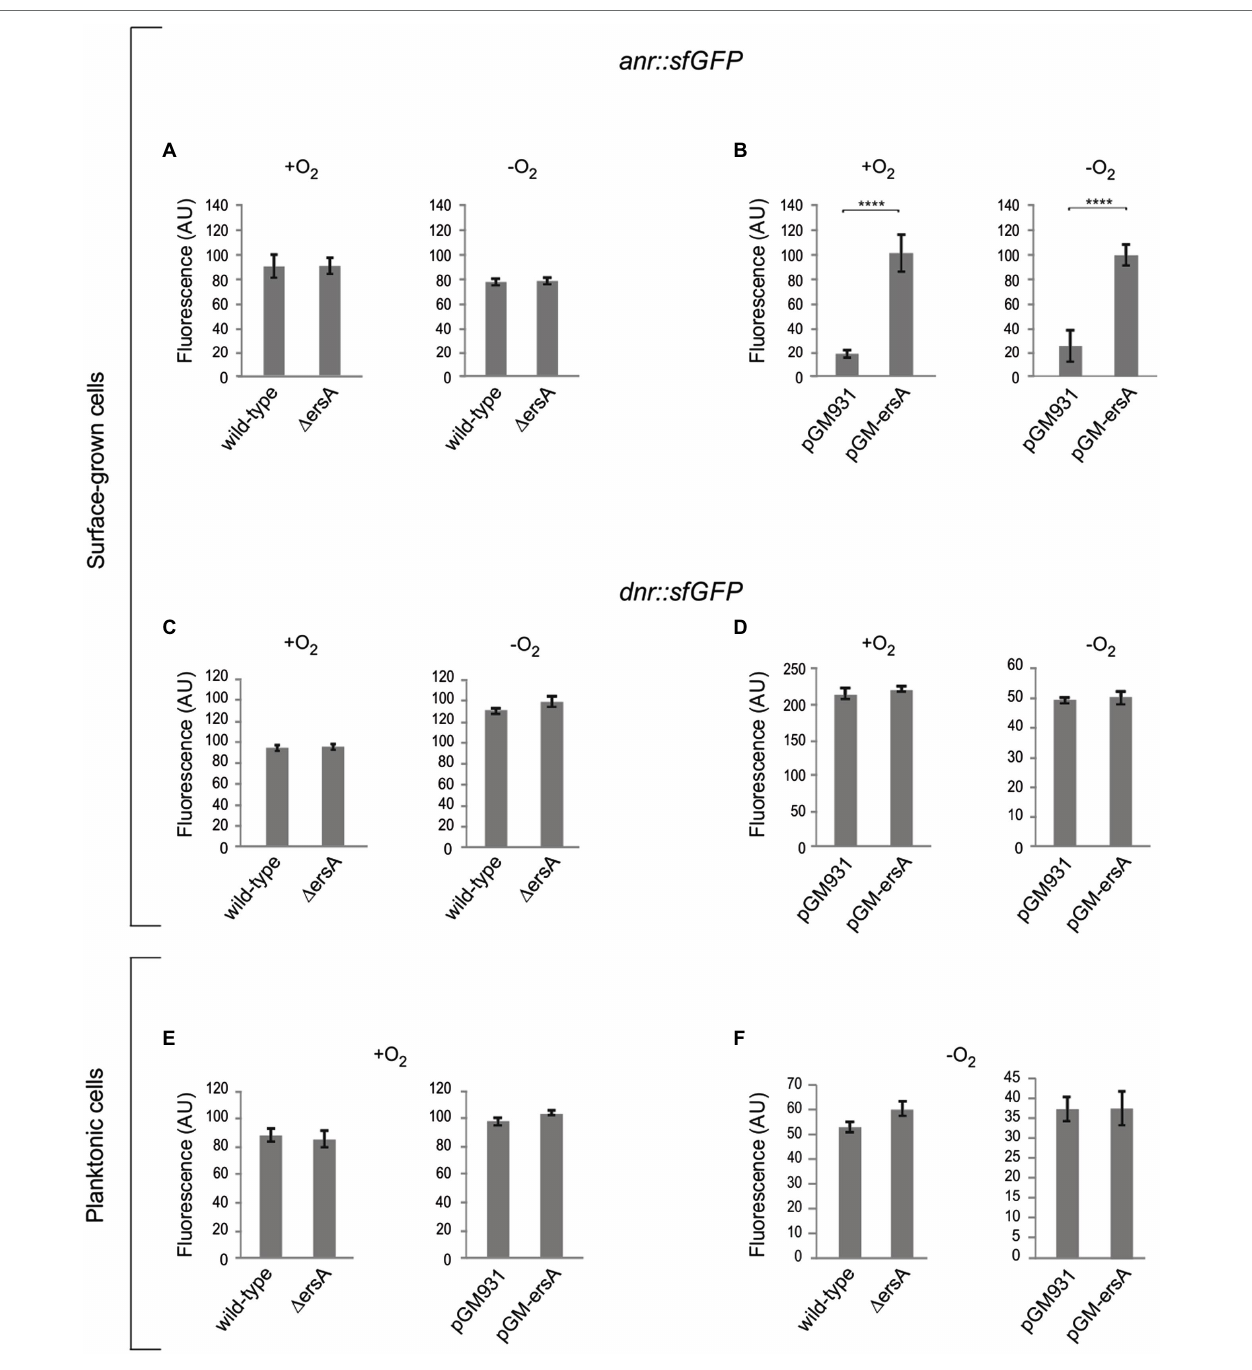
FIGURE 2 | Analysis of the ErsA-mediated modulation of the anr::sfGFP and dnr::sfGFP translational fusions in surface-grown and planktonic cells, in both aerobic and anaerobic conditions. Fluorescence polarization in arbitrary units (AU) resulting from the translational fusions in PAO1 wild-type and Δ ersA strains, and in PAO1 strains with wild-type background harboring the pGM- ersA vector for ErsA overexpression, or the empty vector pGM931 are reported. (A) Comparison of the fluorescence resulting from the translational fusion anr::sfGFP in surface-grown PAO1 wild-type and Δ ersA mutant cells. (B) Comparison of the fluorescence resulting from the translational fusion anr::sfGFP in surface-grown PAO1 wild type harboring the pGM- ersA vector for ErsA overexpression, or the empty vector pGM931. (C) Comparison of the fluorescence resulting from the translational fusion dnr::sfGFP in surface-grown PAO1 wild-type and Δ ersA mutant cells. (D) Comparison of the fluorescence resulting from the translational fusion dnr::sfGFP in surface-grown PAO1 wild type harboring the pGM- ersA vector for ErsA overexpression, or the empty vector pGM931. (E) and (F) Comparison of the fluorescence resulting from the translational fusion dnr::sfGFP in planktonic PAO1 wild-type and Δ ersA mutant cells, and PAO1 wild type harboring the pGM- ersA vector for ErsA overexpression, or the empty vector pGM931, respectively. Statistical significance by t -test is indicated as: **** p <